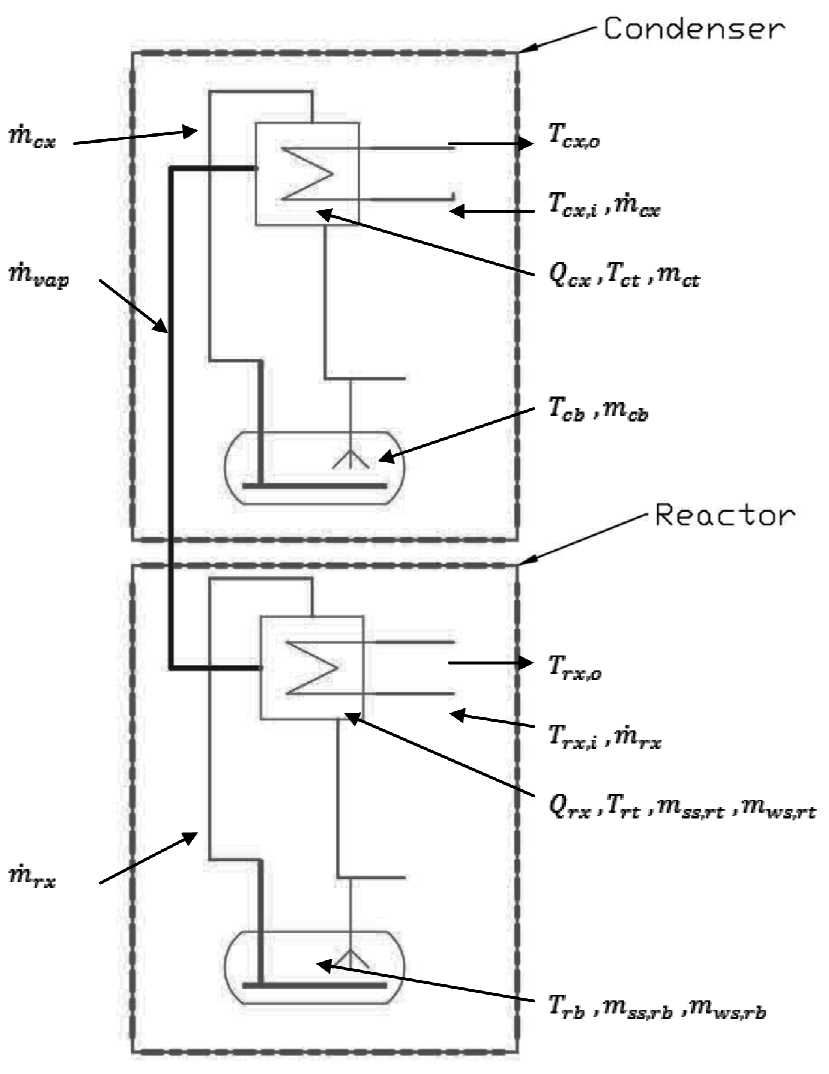
Figure 1. Schematic drawing of the thermo-chemical accumulator (TCA)